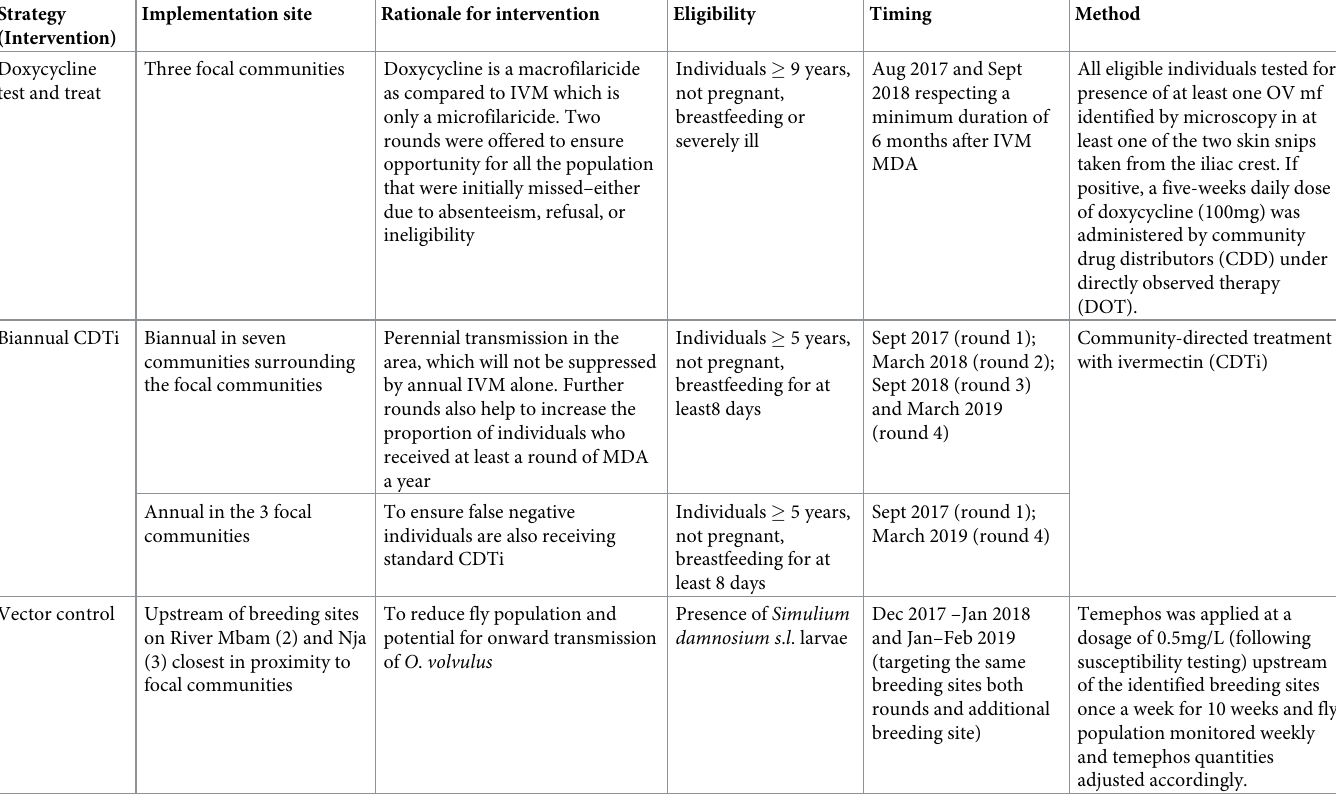
Table 1. Implementation of the various AIS